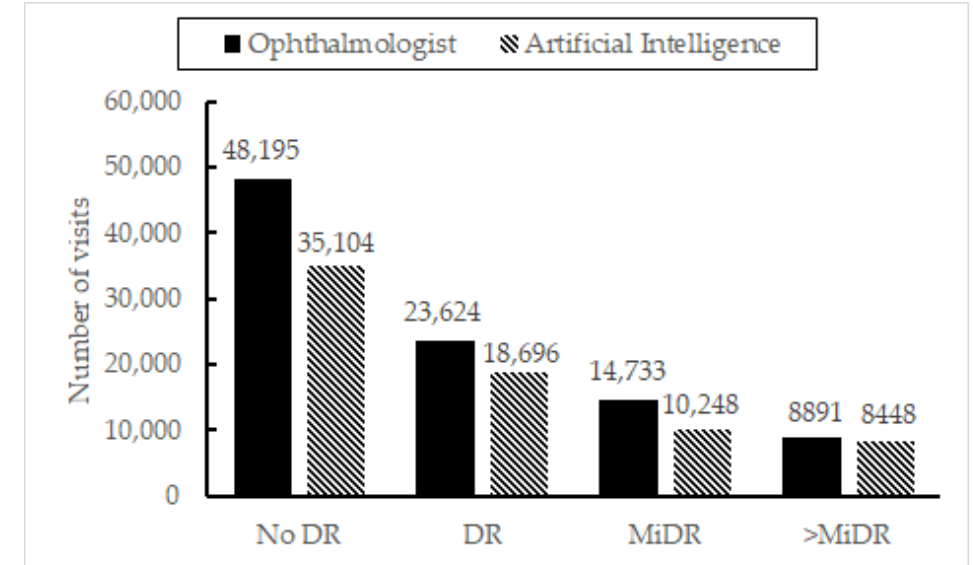
Figure 4. Number of diabetic retinopathy cases detected by the artificial intelligence vs. gold standard (ophthalmologists) for segments B and C.